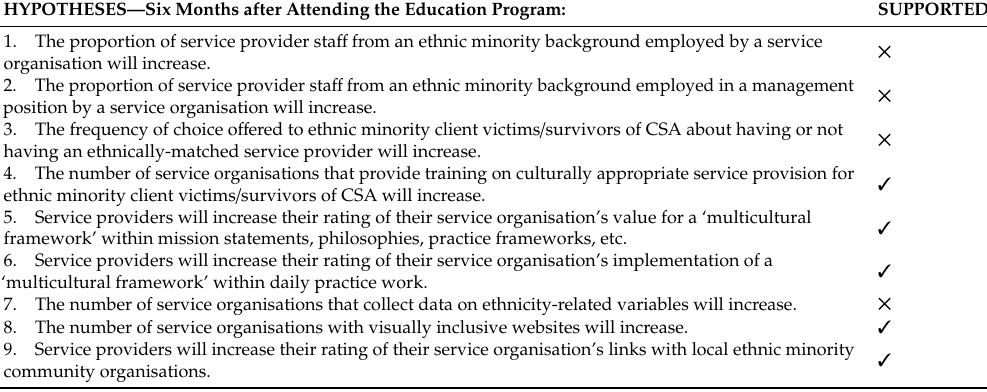
Table 4. Summary of the overall results for all nine